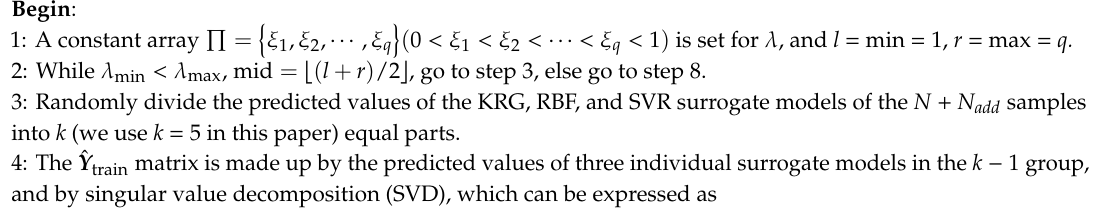
Algorithm 2 Search for the optimal regularization parameter λ